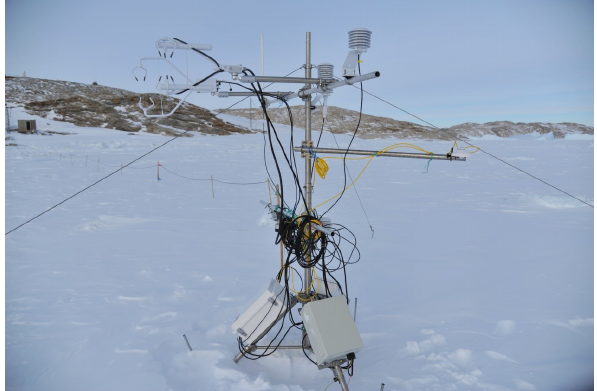
Figure 3. Painting removed where it was apparently impacted on the knuckle of side claw (first sonic path) among the top three sonic transducer claws of the IRGASON sonic anemometer (serial no.: